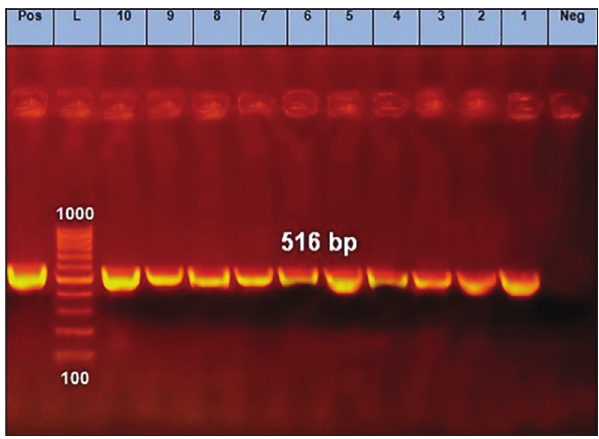
gene). Lane=Lanes TEM gene at TEM